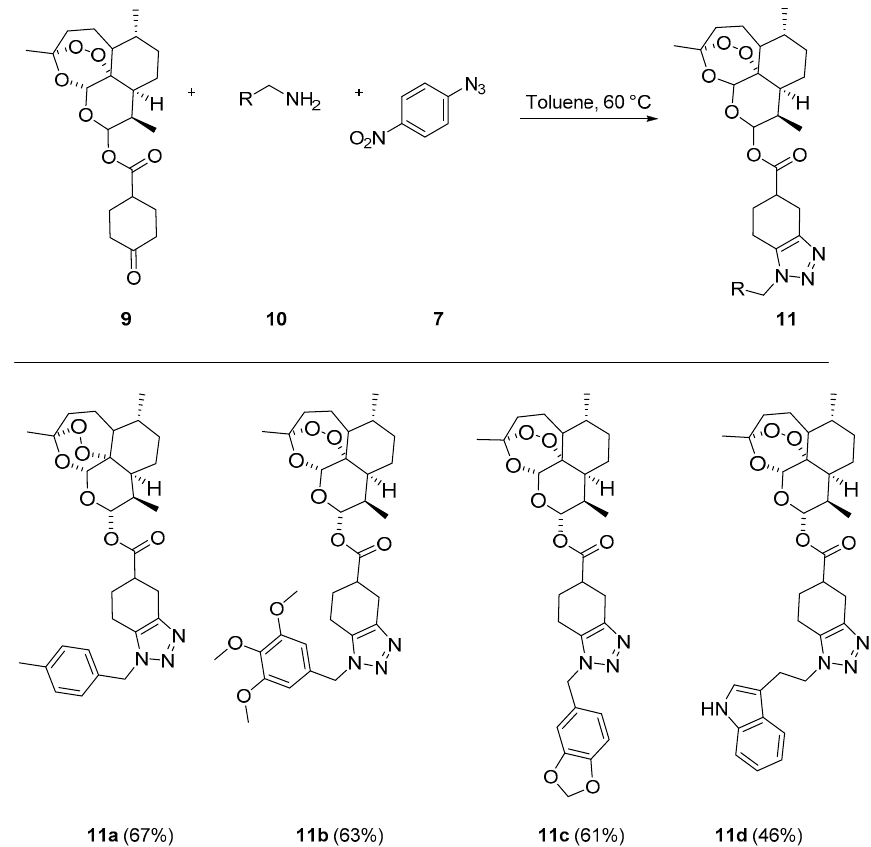
Table 2. Substrate scope with respect to amines a .